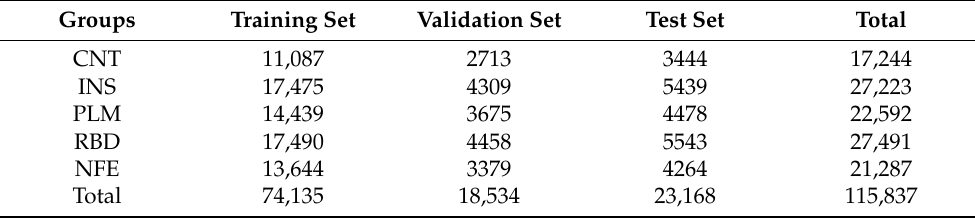
Table 2. ECG datasets for the training, validation, and test sets in this